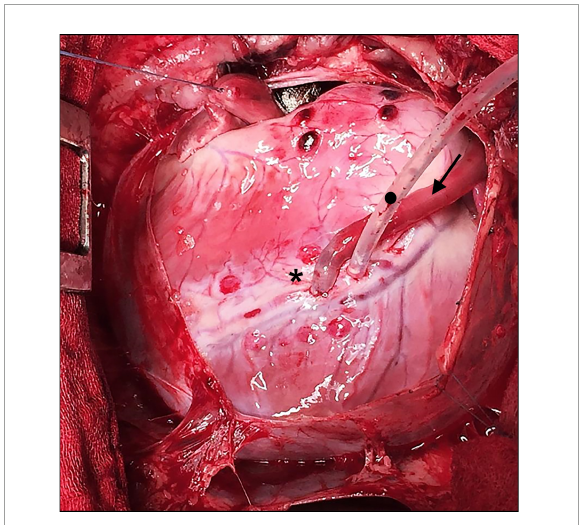
FIGURE2 Intraoperative situs during off-pump coronary artery bypass grafting (CABG). Bacterial cellulose (BC) graft as a coronary bypass (arrow in direction of flow) after distal anastomosis to the occluded left anterior descending (LAD) (*) using an elastic band with a tourniquet ( • ).